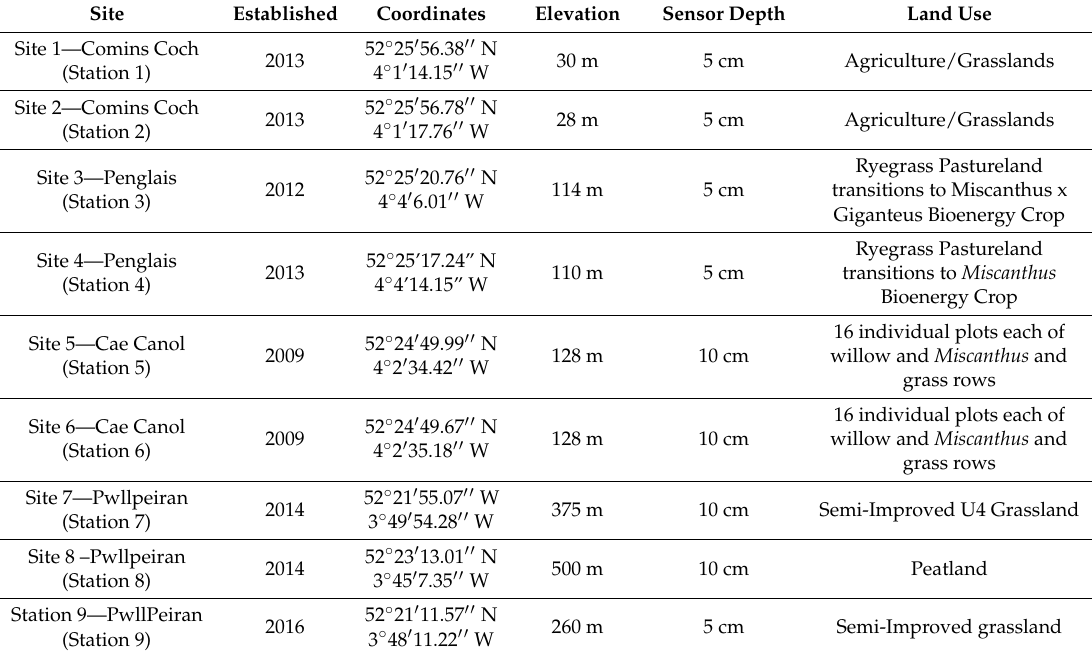
Table 1. Summary of the main characteristics of the sites belonging to